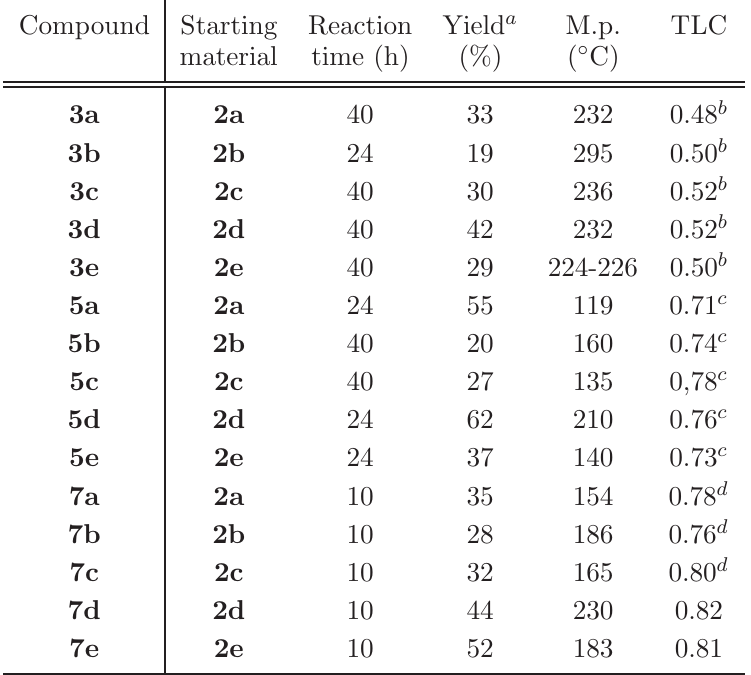
Table 1 Tryptamine derivatives